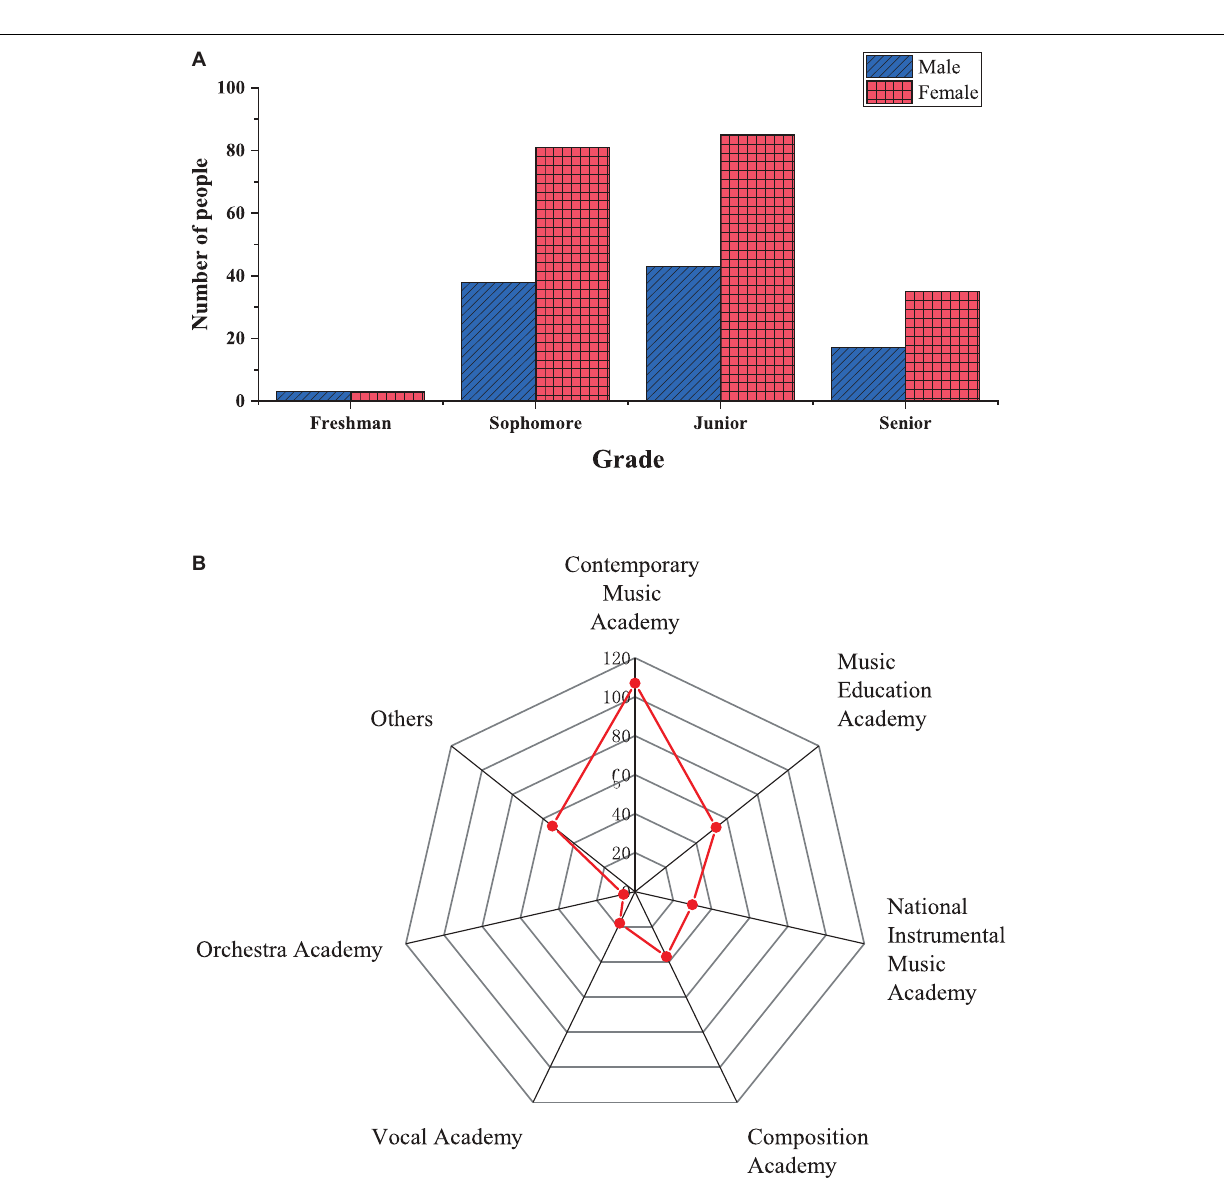
FIGURE 2 | Distribution of sample structure [ (A) is the grade and gender distribution of the sample, and (B) is the major distribution of the